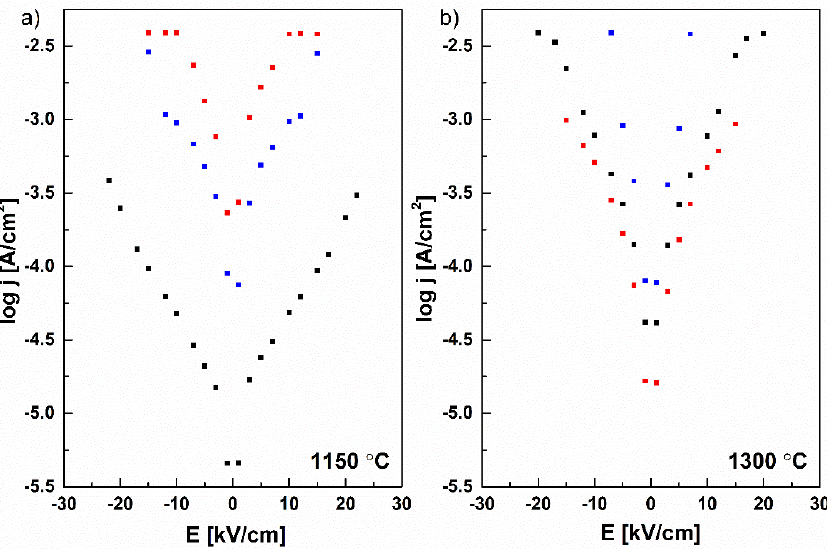
Figure 12. Leakage current measurements for the samples ( a ) sintered at 1150 °C, ( b ) sintered at 1300 ◦ C (BaTiO 3 /NiFe 2 O 4 —black, BaTiO 3 /ZnFe 2 O 4 —blue, and BaTiO 3 /Ni 0.5 Zn 0.5 Fe 2 O 4 —red) as 1300 °C (BaTiO 3 /NiFe 2 O 4 — black, BaTiO 3 /ZnFe 2 O 4 — blue, and BaTiO 3 /Ni 0.5 Zn 0.5 Fe 2 O 4 — red) as log j — log j—E E dependence.